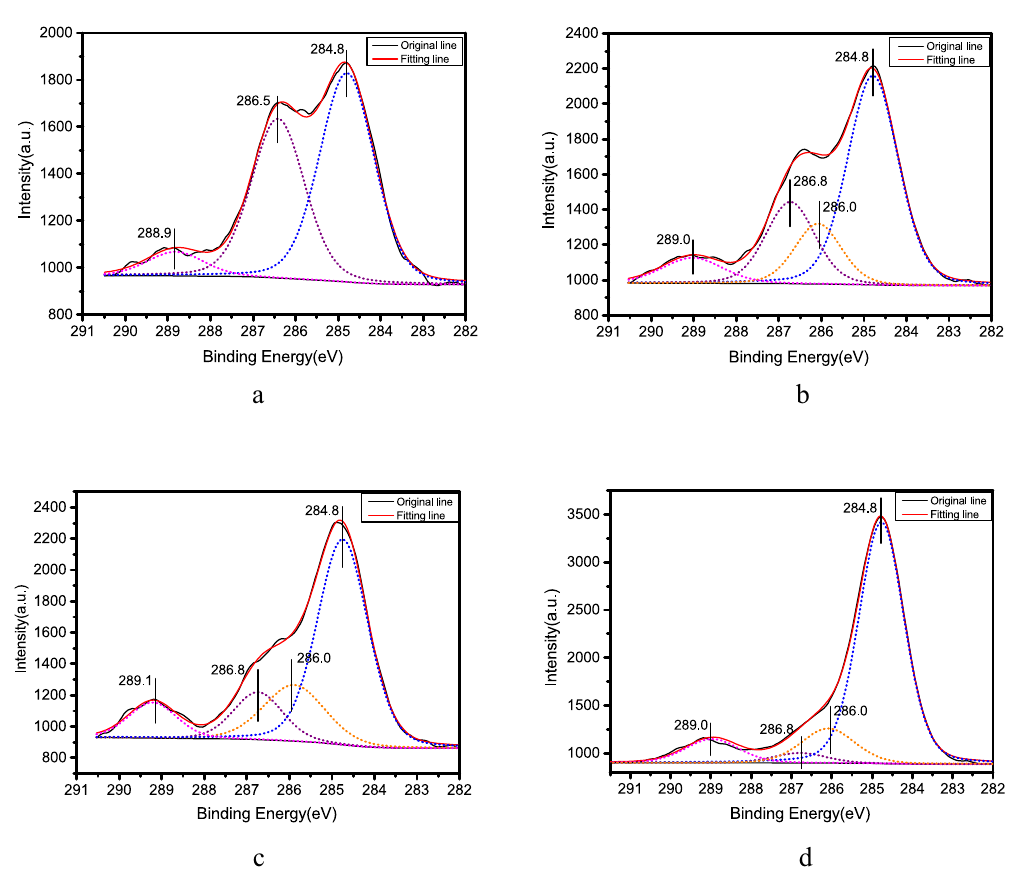
Figure 8. C1s XPS core-level spectra of α -HH whiskers prepared with different concentration of CTAB in glycerol (65 wt%)-water solutions with 5% KCl (by weight of FGD gypsum) at 90 °C for 45 min (( a ) 0; ( b ) 0.05%; ( c ) 0.15%; ( d )